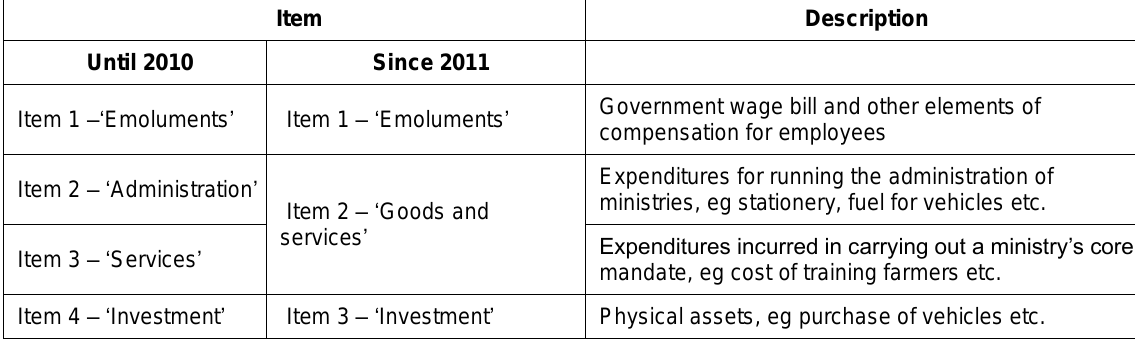
Table 1: Categorisation of Ghana’s budget expenditure items before and after 2011 Item